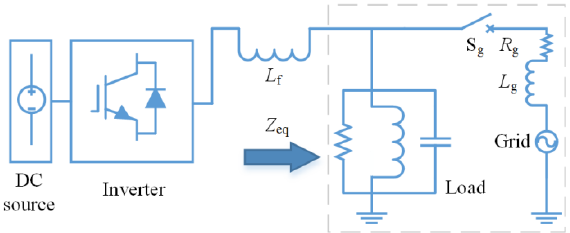
Figure 1. Inverter-based distributed generation (DG).